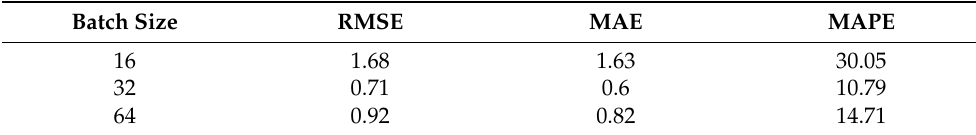
Table 4. The impact of batch size on model performance. Batch Size RMSE